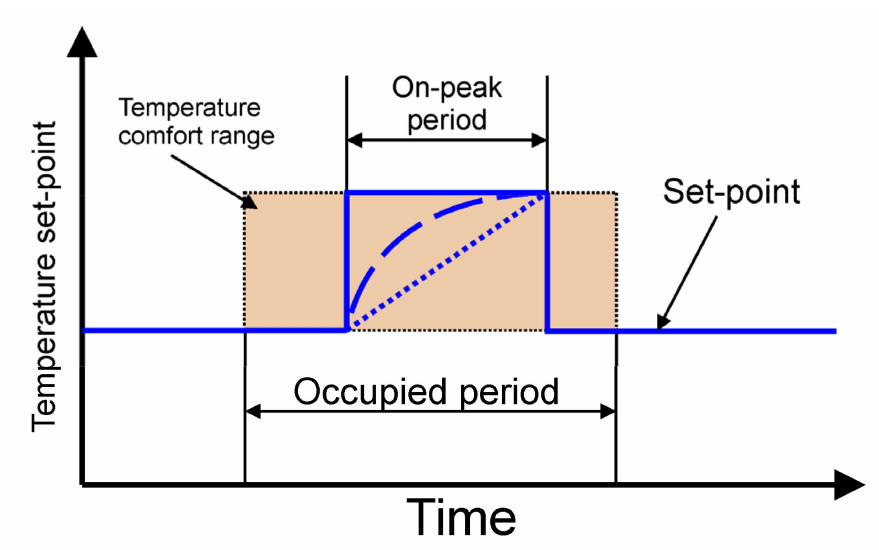
Figure 3. Hourly profiles of the set-point